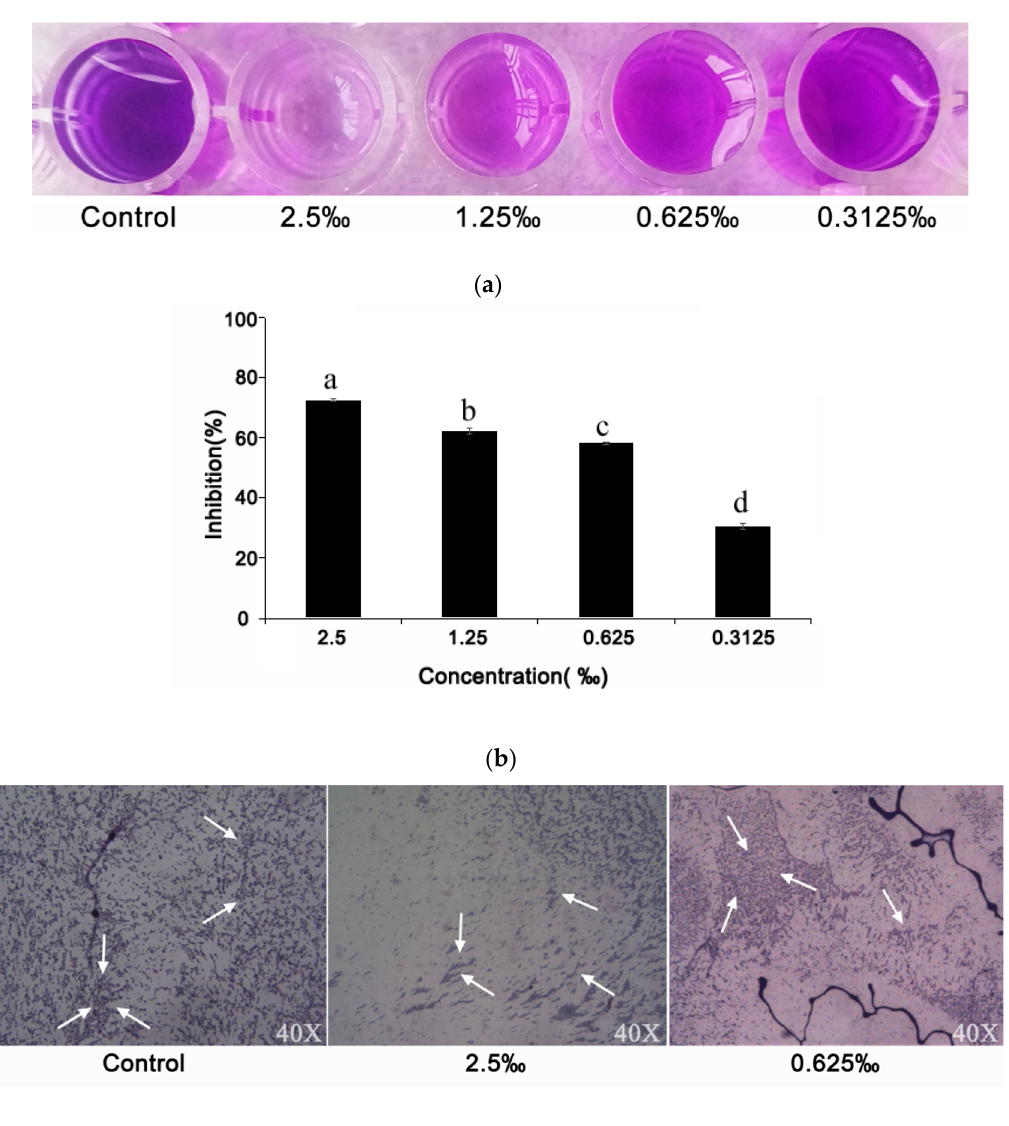
Figure 5. The e ff ect of di ff erent concentrations of C. camphora EO on the biofilm. ( a ) Dyeing e ff ect of crystal violet on biofilm of C. violaceum treated with di ff erent concentrations of C. camphora EO. ( b ) Quantitative analysis of the inhibition of biofilm biomass in C. violaceum by C. camphora EO. ( c ) E ff ect of C. camphora EO on biofilm formation. Mean values of triplicate independent experiments and SD are shown. Bars indicate standard errors and di ff erent letters ( a – d ) above the bars represent significant di ff erences ( p < 0.05).